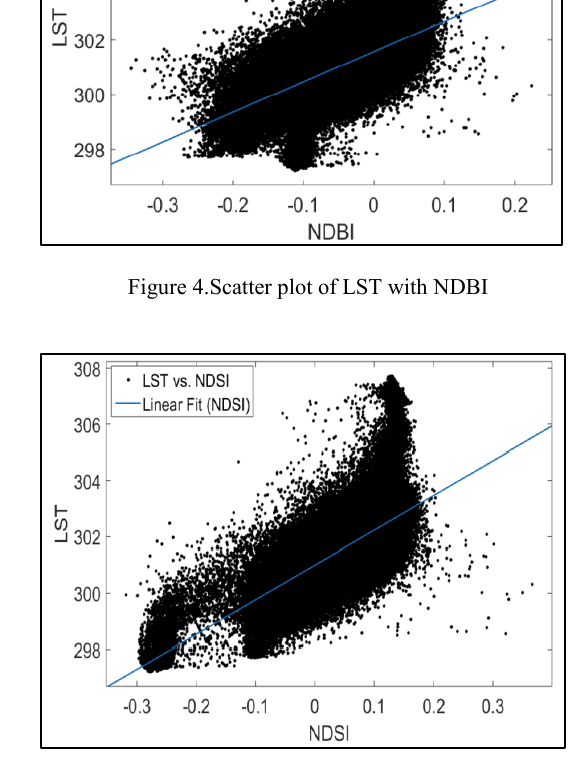
Figure 5.Scatter plot of LST with